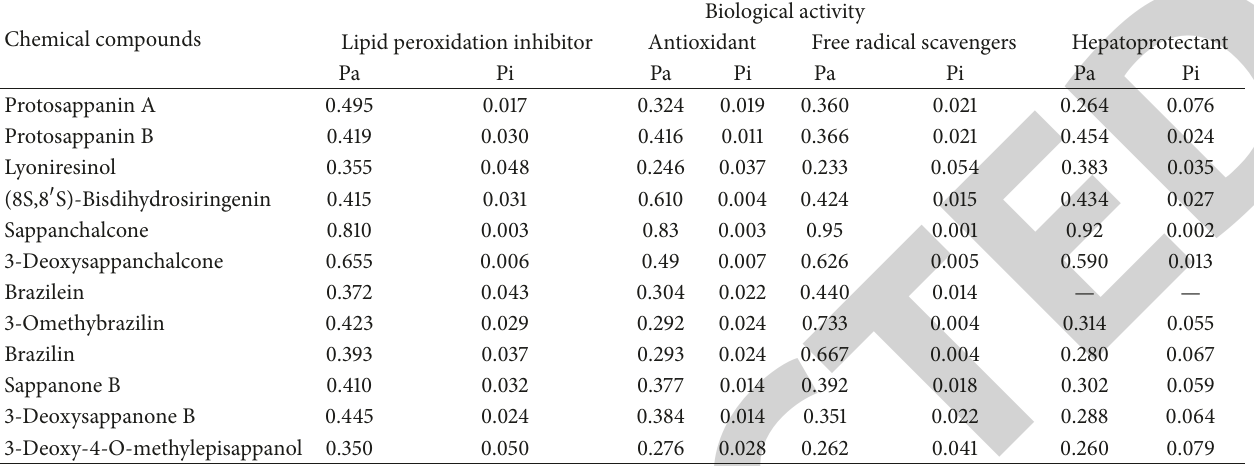
Table 1: Part of the predicted biological activities spectra for the chemical compounds of CS extract. Chemical compounds